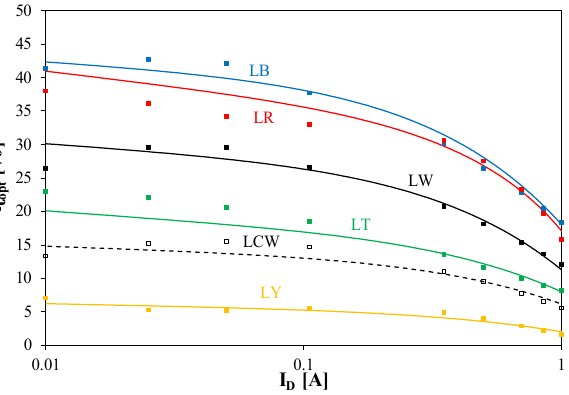
Figure 6. Computed and measured dependence of the surface power density E e on forward current.